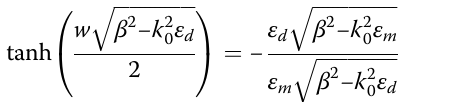
Fig. 4 Intensity distribution of the transverse component | E r | 2 in the focal plane. The inset shows the elliptical-shape focus. The focal length is 1425 nm (a deviation of 9.62%). | E r | 2 occupies 20.2% of the total electric energy. The DOF is ~1.41 λ 0